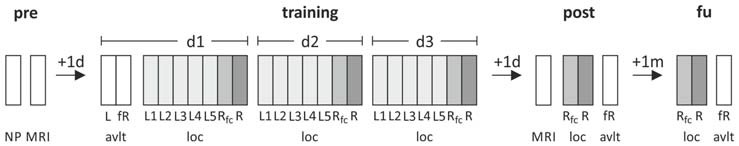
Study design. Participants underwent a training of the object-location paradigm in five blocks followed by free recall and recognition trials on three consecutive days. As a control task, Rey Auditory Verbal Learning Test (AVLT) was administered. Prior to and 1 day after training a structural MRI, including high-resolution T1 and diffusion-weighed images, was assessed. Post-assessment included recall and recognition testing which was repeated in a 1-month follow-up assessment. NP, neuropsychological testing; MRI, magnetic resonance imaging; loc, object-location paradigm; avlt, auditory verbal learning task; L, learning; Rfc, 3-alternative-forced-choice recall task (AFC); R, recognition; fR, free recall.